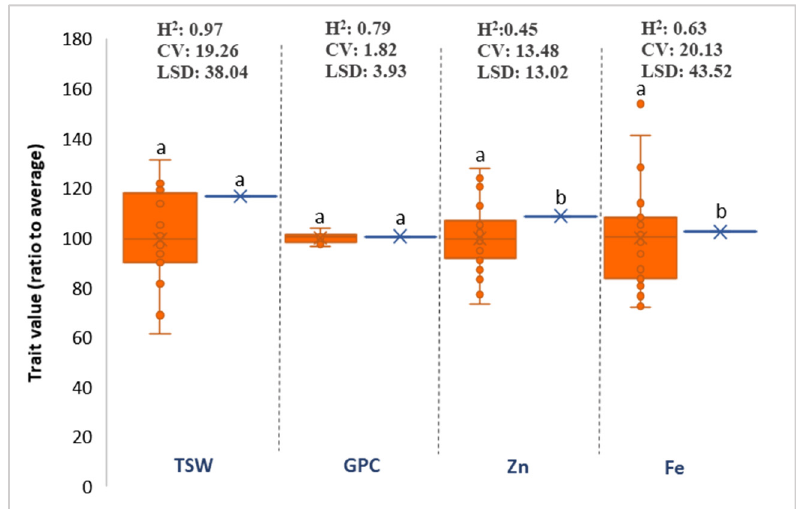
Figure 7. Food transformation characteristics of CWR-derived elite lines of lentil (orange) against the commercial check Bakria (blue). Values are expressed as ratio-to-average to plot them together. The letters “a” and “b” indicate significant differences at p < 0.05. TSW; 1000-seed weight, GPC; grain protein content, Zn; zinc content, Fe; iron content.